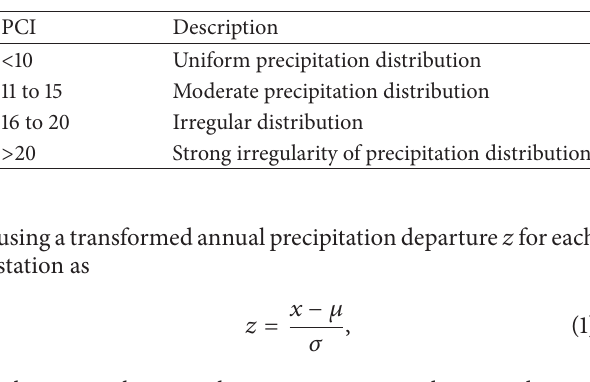
Table 1: Classification of PCI values.